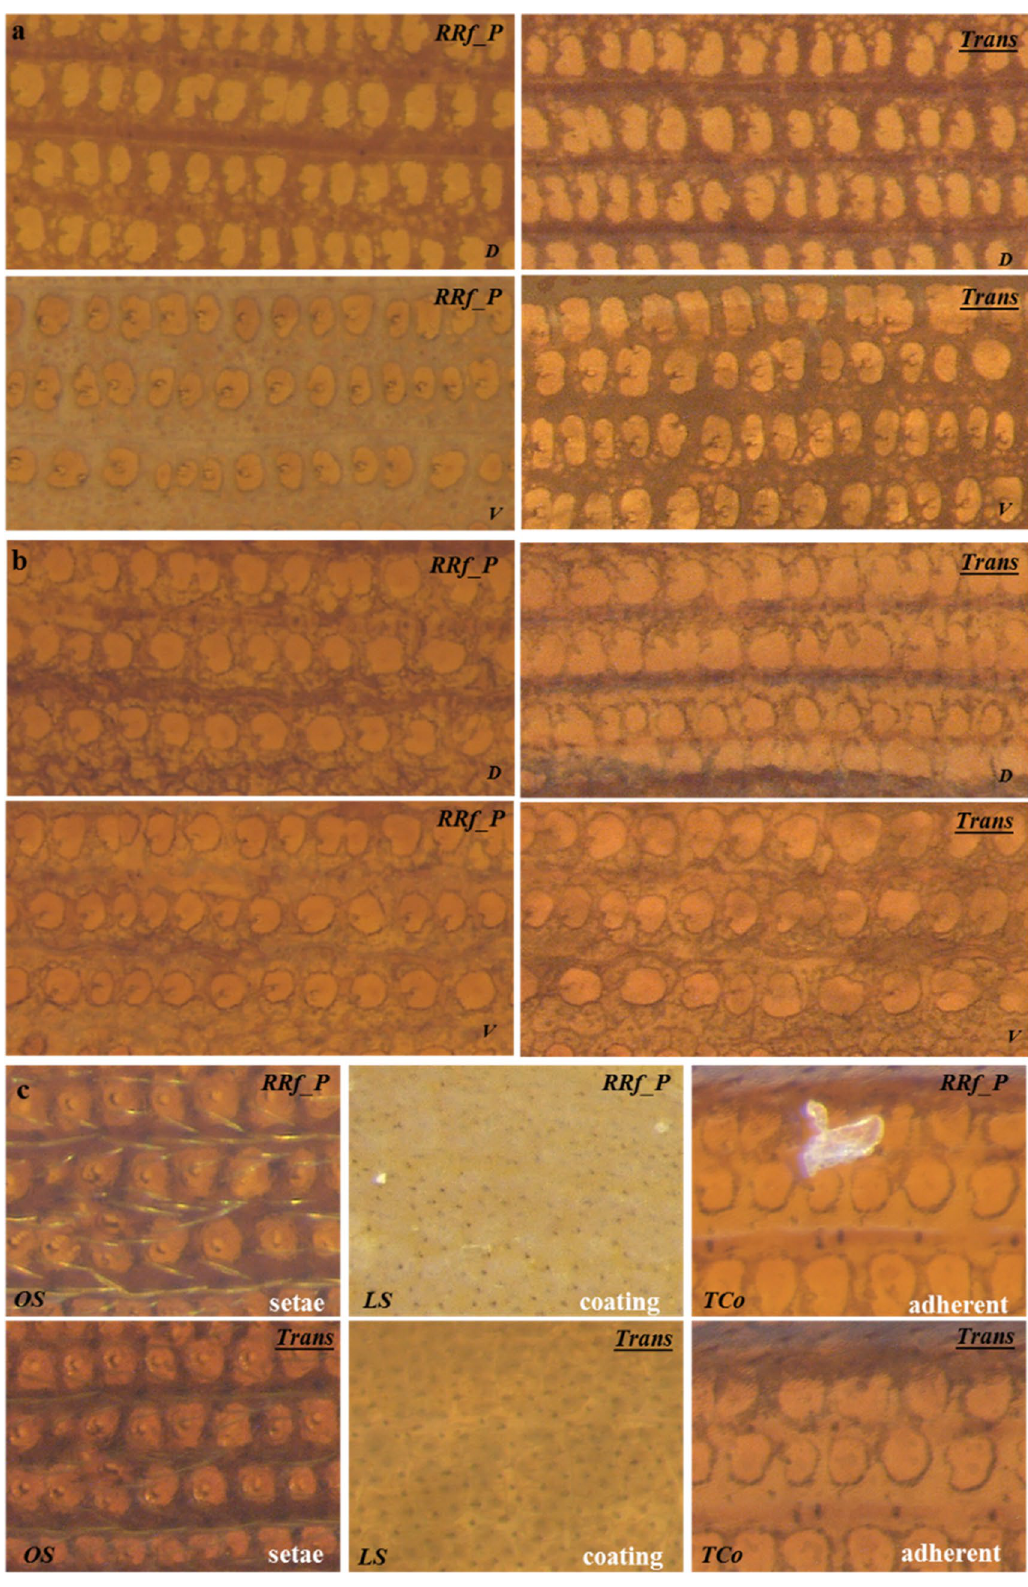
Figure 3. Acquired patterns on either side of elytra dorsal (D) & ventral (V) sides for maximum visualization of the patterns and to compare the two different illumination systems, RRf_P and Trans , for (a) T. castenium , (b) T. confusum both belonging to the genus Tribolium ; and are well known for their remarkably similar appearance; and (c) in visualizing surface features in O. surinamensis (OS), L. serricorne (LS), and T. confusum (TCo). Although, both systems seemed equally good for visualizing elytral patterns, the Trans system was found to be the least affected by minor surface features such as setae, thin surface coatings or occasional adherents, making it more advantageous for the imaging